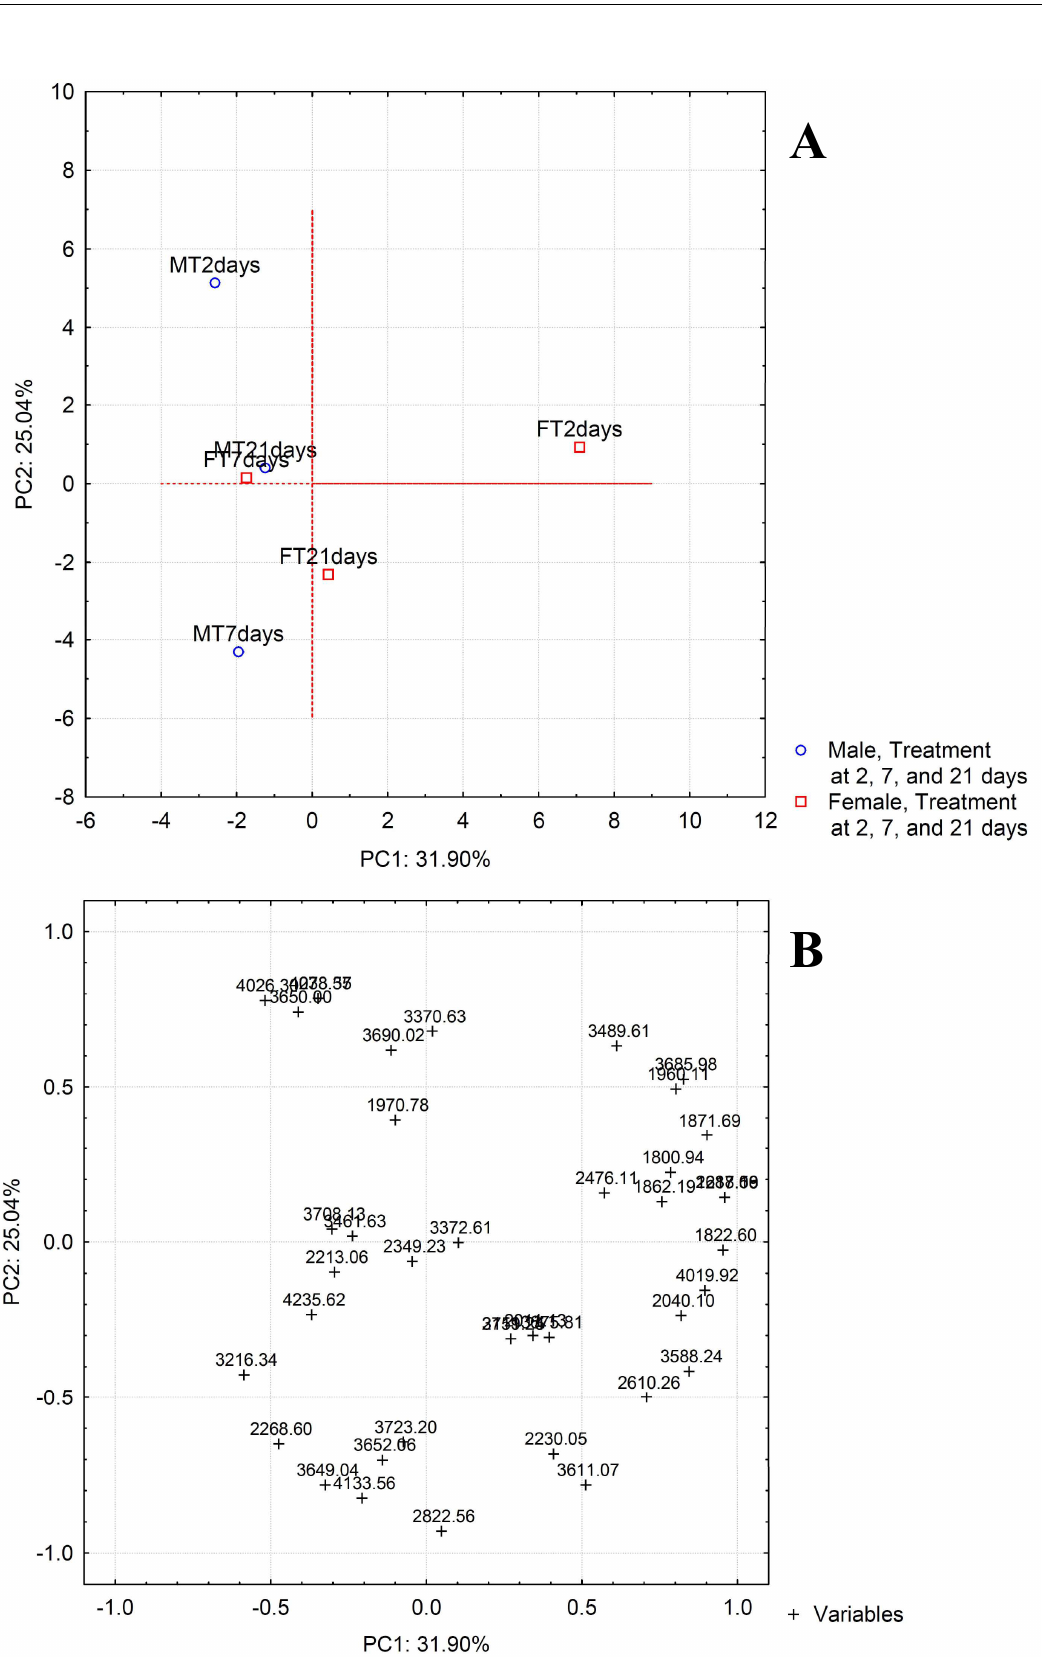
Figure 5. Scores ( A ) and loadings ( B ) plots obtained by Principal Component Analysis applied to the ratio of the signals of treated specimens to the signals of the control